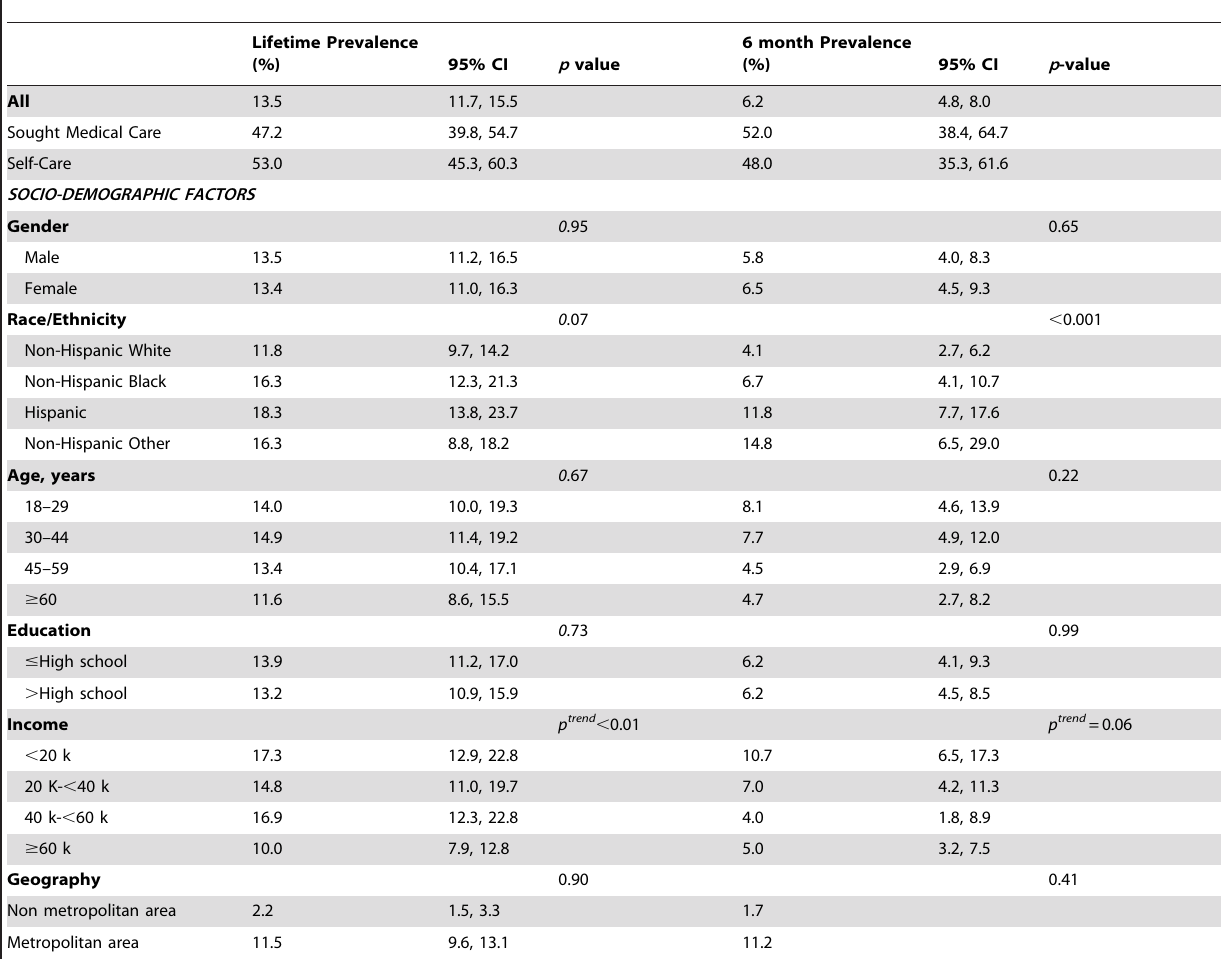
Table 2. Lifetime Prevalence and Subsequent Six-month Occurrence of SSTIs similar to CA-MRSA by Selected